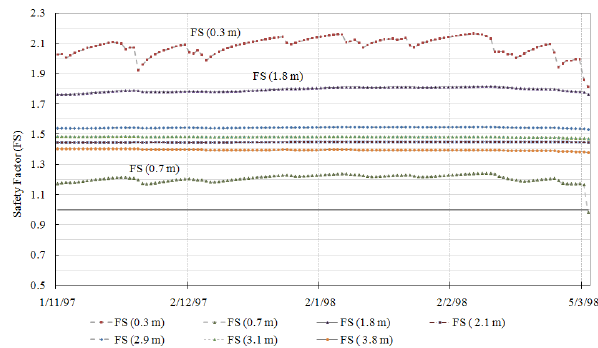
Figure 12. Slope safety factor depending on pore-water pressures and soil mechanism properties at different depths from the ground